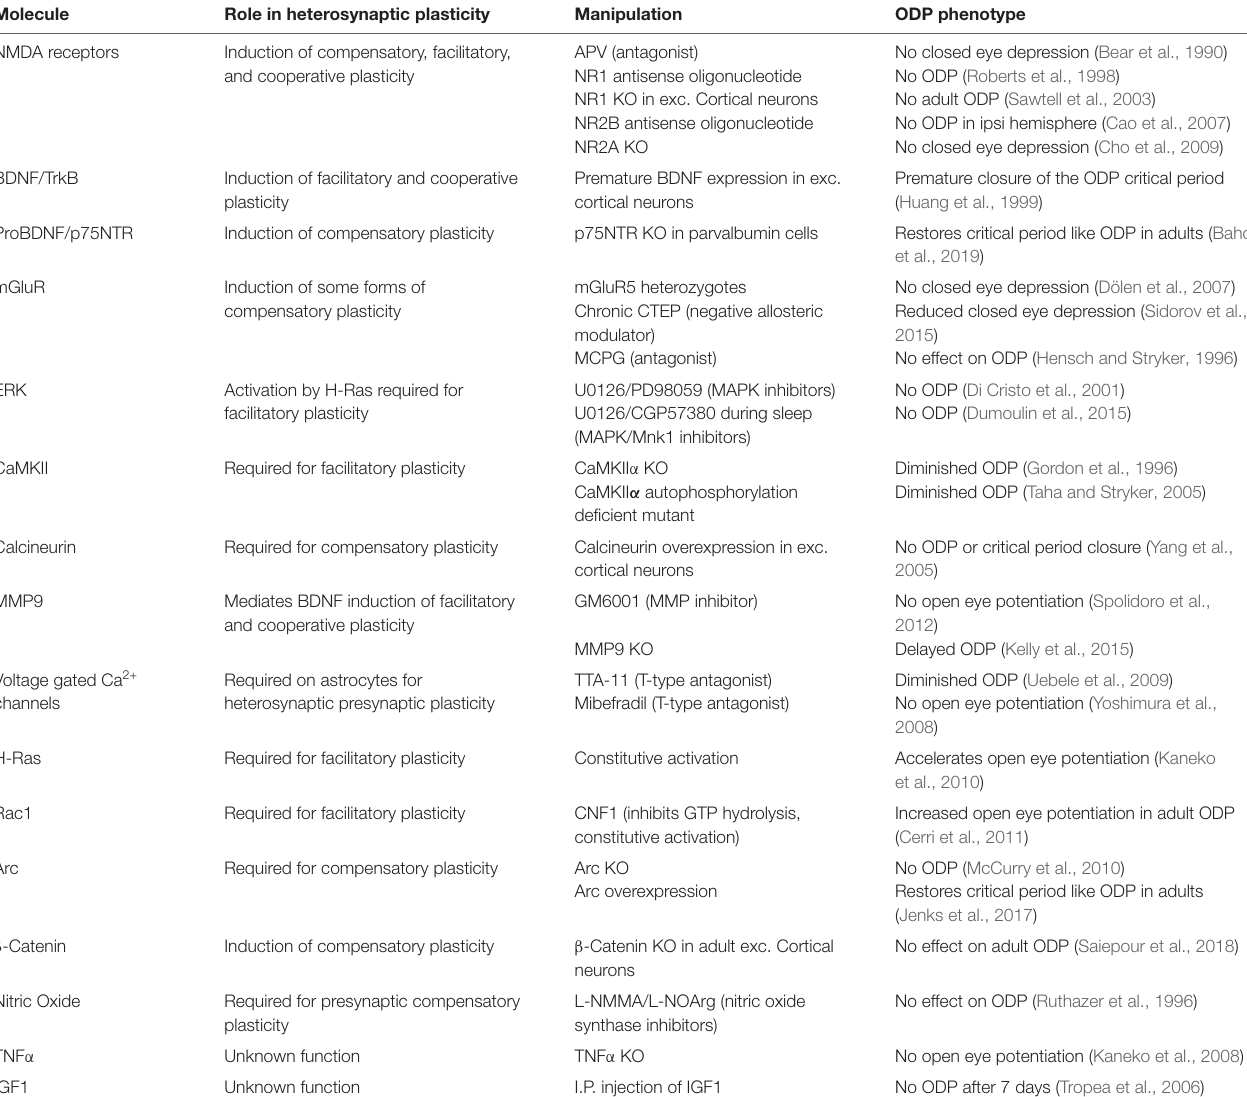
TABLE 1 | The molecular overlap between heterosynaptic and ocular dominance